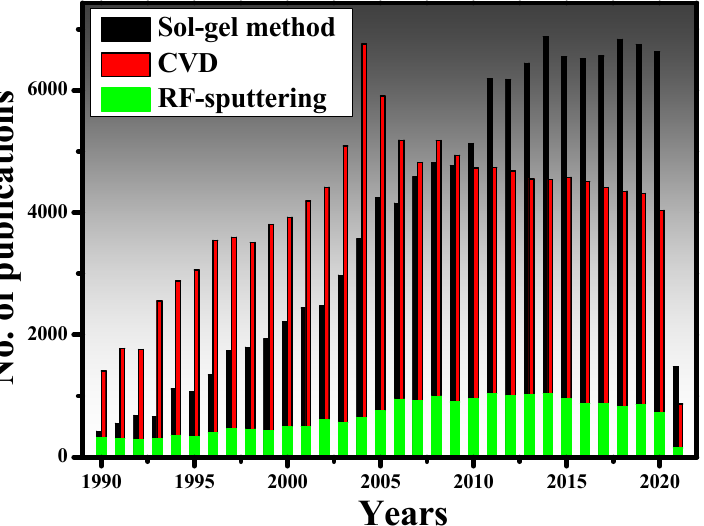
Figure 4. The number of publications related to CVD, RF-sputtering, and sol-gel method, indexed in the Scopus database. The keywords “sol-gel dip coating method”, “Chemical vapor deposition” and “RF-sputtering” were used during the search.